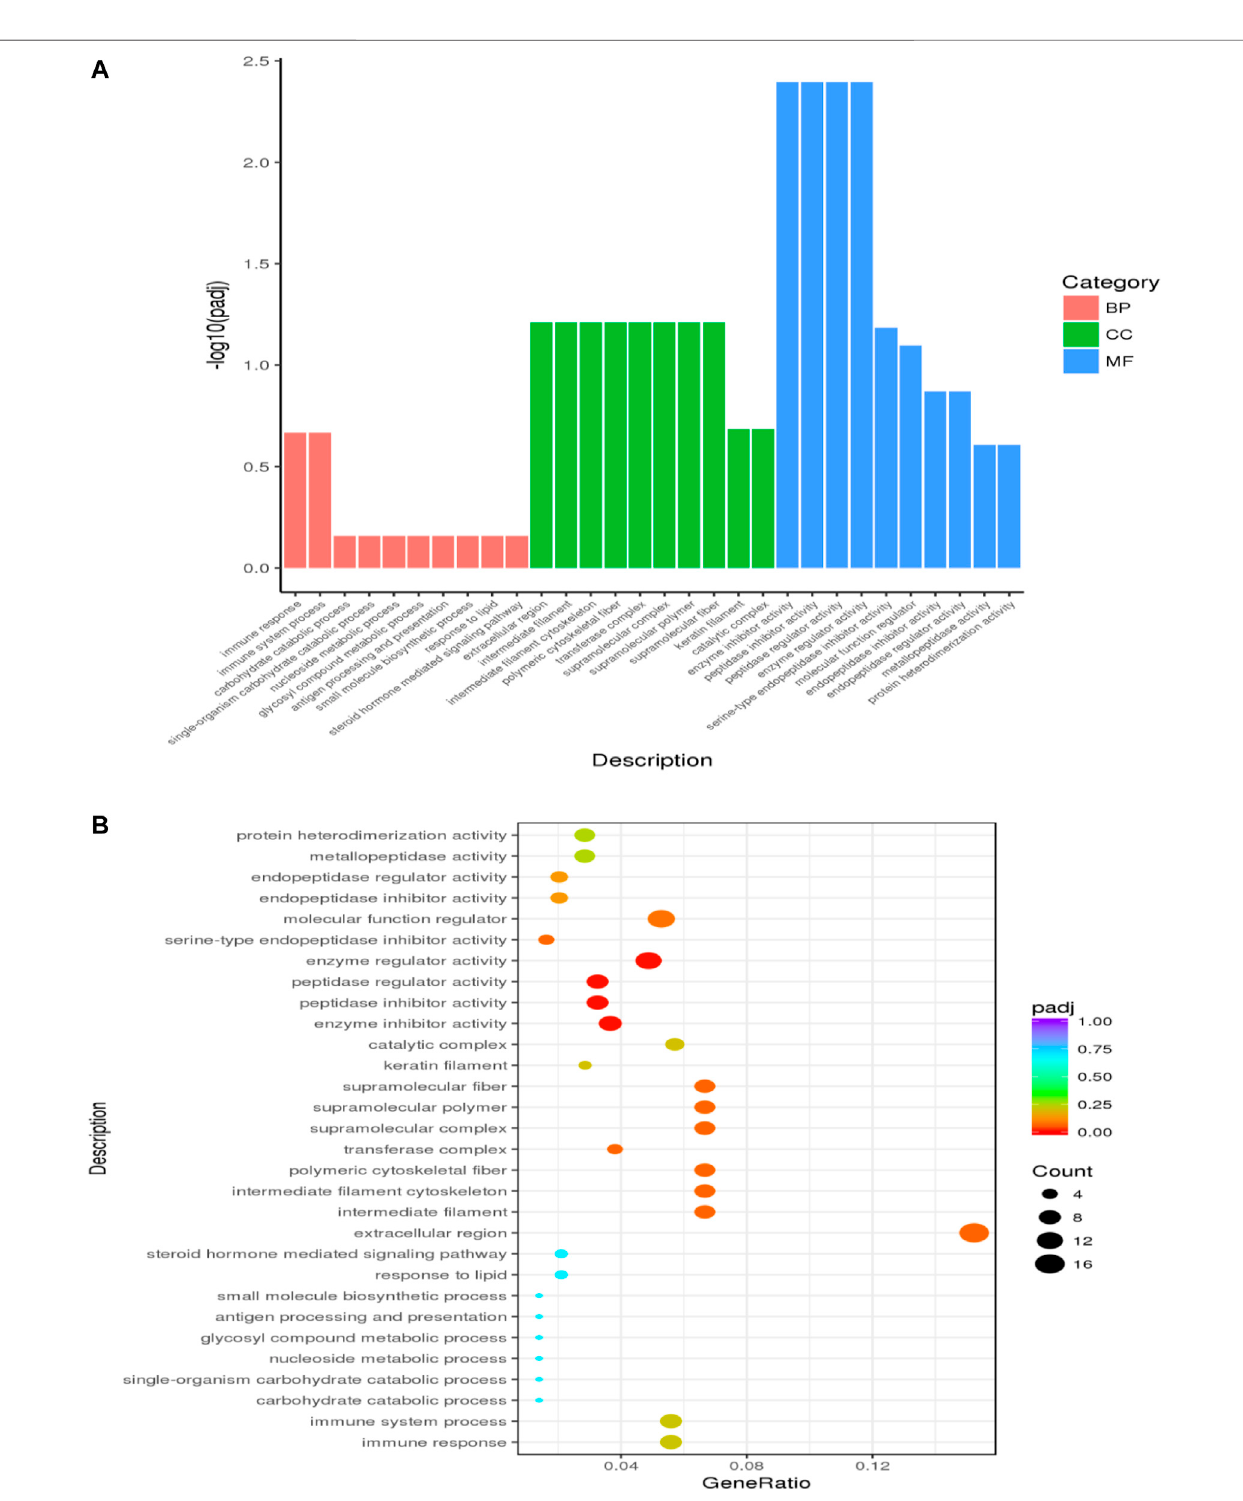
FIGURE 5 | Enrichment analysis in LCG. (A) GO enrichment analysis histogram, the abscissa is the GO term, and the ordinate is the signi fi cance level of GO term enrichment. Height was positively correlated with the signi fi cance. Different colors represent BP, CC, and MF. (B) Scatter plot of enrichment analysis, the horizontal coordinateinthePanelistheratioofthenumberofdifferentgenesannotatedtotheGOtermandthetotalnumberofdifferentgenes.TheordinateistheGOterm,thesizeof pointsrepresentsthe numberofgenes annotated tothe GOterm, and the level ofenrichment variesfrompurpletored. (C) KEGGenrichment analysishistogram, the horizontal coordinate in the panel is the KEGG pathway, and the longitudinal coordinate is the signi fi cance level of channel enrichment, and the height of the histogram indicatesthedegreeofenrichment. (D) ScatterplotofKEGGenrichmentanalysis,theabscissaistheratioofthenumberofdifferentialgenesannotatedtotheKEGGpathway to the total number of differential genes. The ordinate is the KEGG pathway. The size of the dot represents the number of genes annotated to the KEGG pathway. And the level of enrichment varies from purple to red.